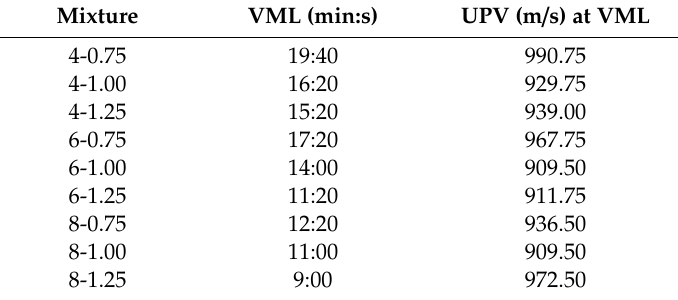
Table 5. Ultrasonic pulse velocities (UPVs) and viscosity measurement limits (VMLs) of AAS pastes.